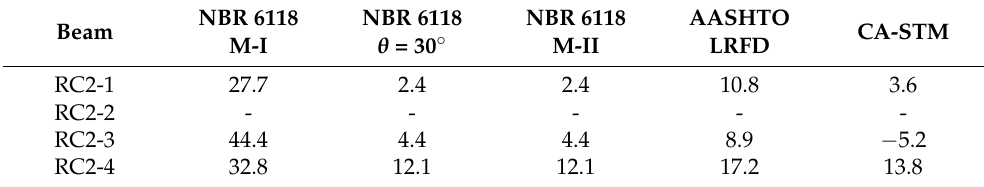
Table 2. Relative errors (%) for the maximum torques for RC beams from Series 1. Beam